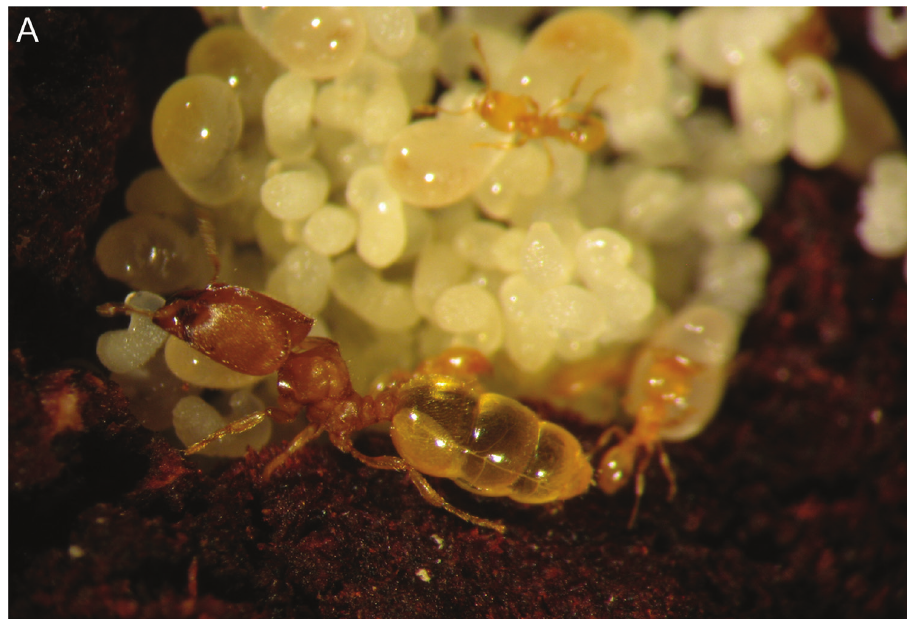
Figure 2. A Major worker (Intermediate 4) of Carebara jajoby (Image by Christian Peeters). workers (e.g . C. jajoby sp. n. and C. nosindambo ). We did not report any major